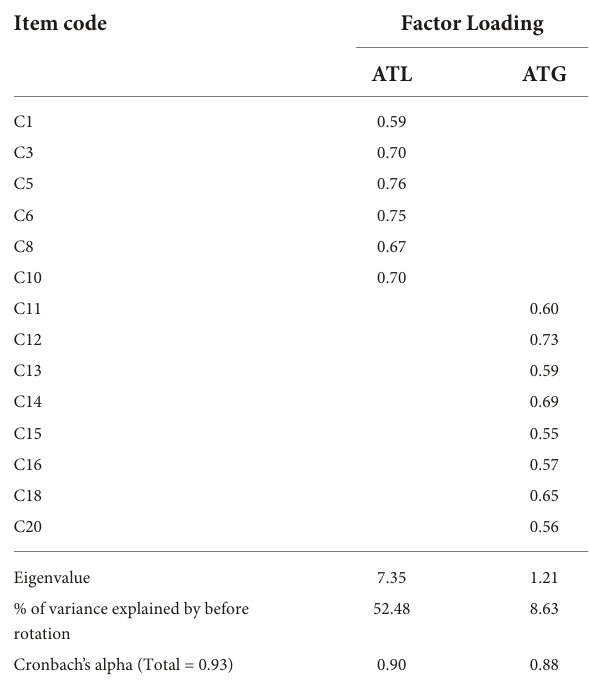
TABLE 4 Results of the EFA and internal consistency of the ATLG scale.